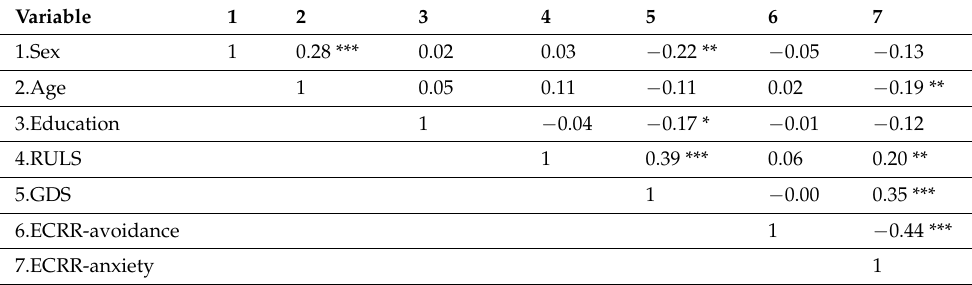
Table 2. Correlation matrix.